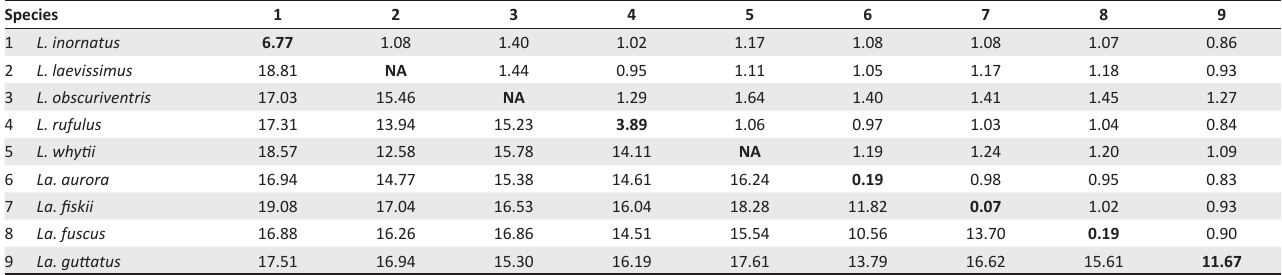
TABLE 2: Sequence divergences (uncorrected pairwise distance values) separating the species of Lycodonomorphus and Lamprophis using cytochrome b ( Cyt-b ). Species